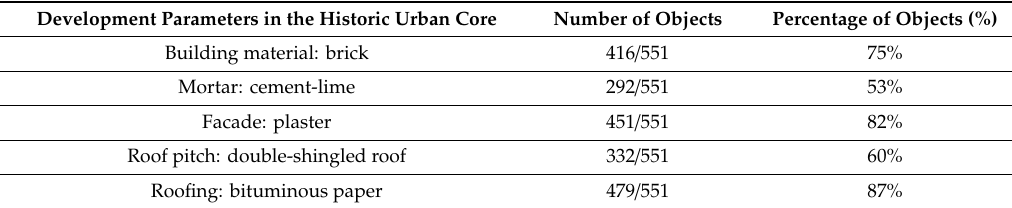
Table 1. Building parameters in the historic urban core.